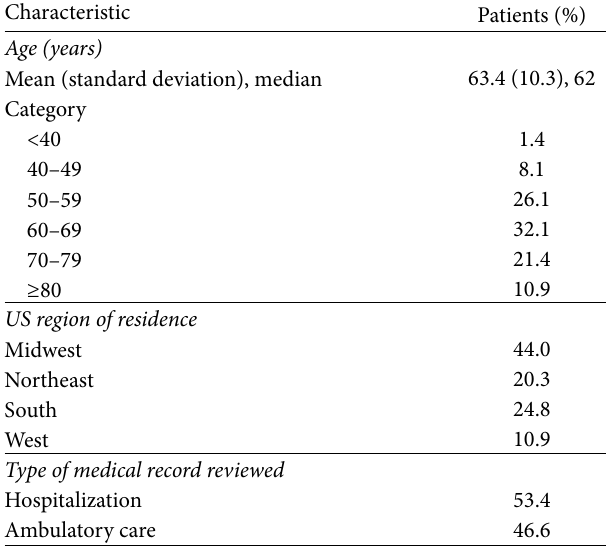
Table 1: Characteristics of the study cohort 𝑁 = 330